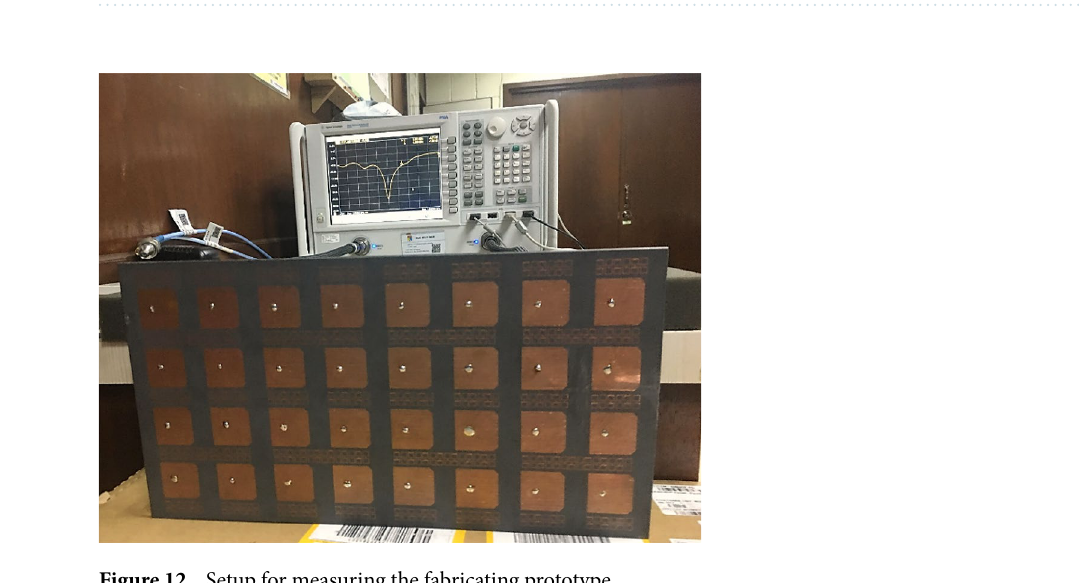
Figure 11. ( a ) Top view, ( b ) bottom view of fabricated single-side prototype.